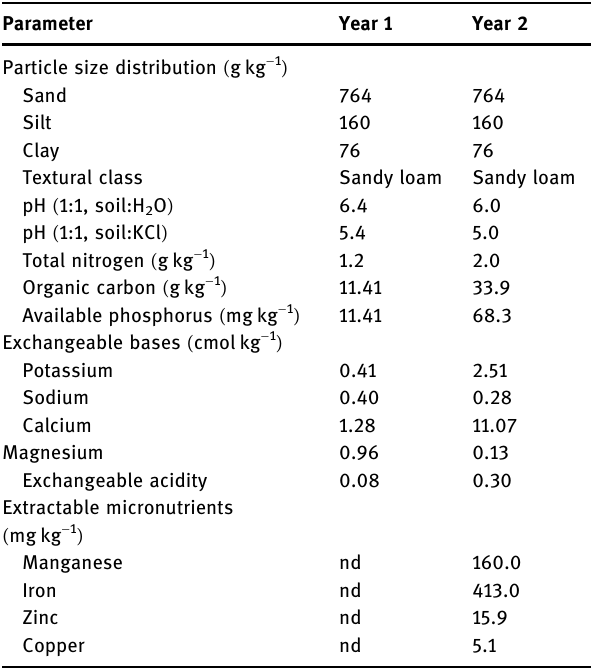
Table 1: Physical and chemical properties of the experimental